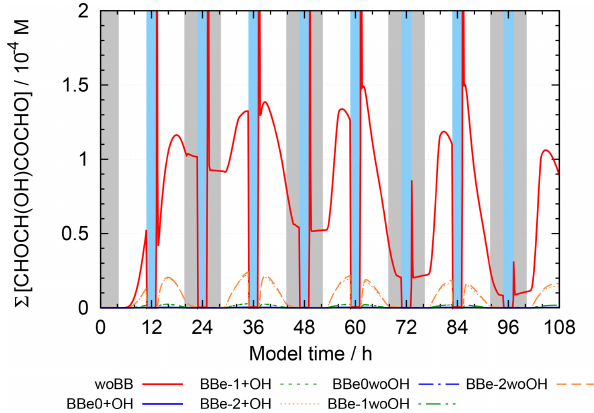
Figure 10. Concentration–time profiles of aqueous 2-oxo-3- hydroxy-succinaldehyde in all hydration forms in the sensitivity runs investigating the decay of polycarbonyl compounds under ur- ban summer conditions with eight cloud passages using the prelim- inary CAPRAM–GECKO-A protocol described in the text. Cloud passages are shaded blue and night-time periods are shaded grey. Scenario names used in the legend are explained in Appendix